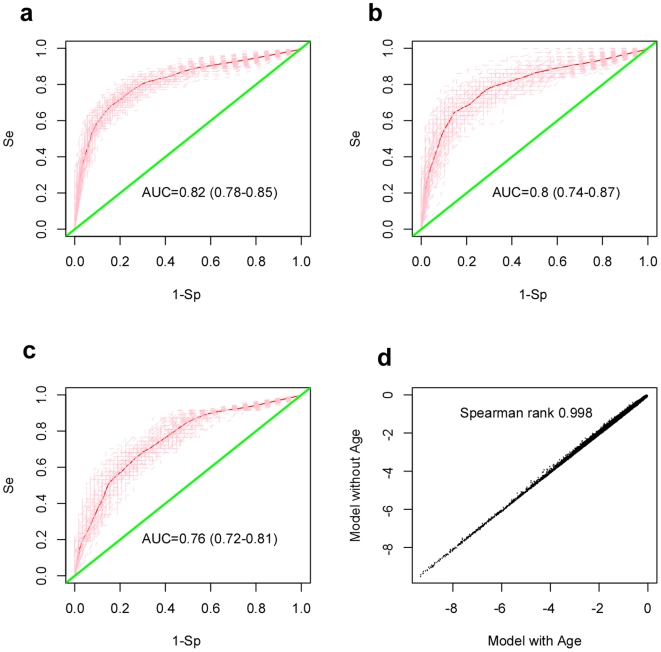
Prediction of tumor presence by a DNAm signature in blood.
a–b) Classification performance of DNA methylation classifiers in a) training sets and b) blind test sets. Training and test sets consisted of blood samples from pre-treatment cases and healthy individuals (Materials and Methods). Average ROC curve over 100 different training/test set partitions with 95% CI envelope in blind test sets. Mean AUC and 95% CI over 100 different partitions are given. c) Classification performance in test sets consisting of healthy controls and post-treatment samples with evidence of active disease. d) Correlation between the ranking of top CpGs discriminating pre-treatment cases from healthy controls in regression models that included age (x-axis) and without age (y-axis) as a co-factor. Plotted are the log10(p-values) for the 25,642 CpG sites, as evaluated from multiple logistic regressions of case/control status against the CpG methylation profile with age as a co-factor (x-axis) and without age as a co-factor (y-axis). Spearman correlation between the two rankings is given.